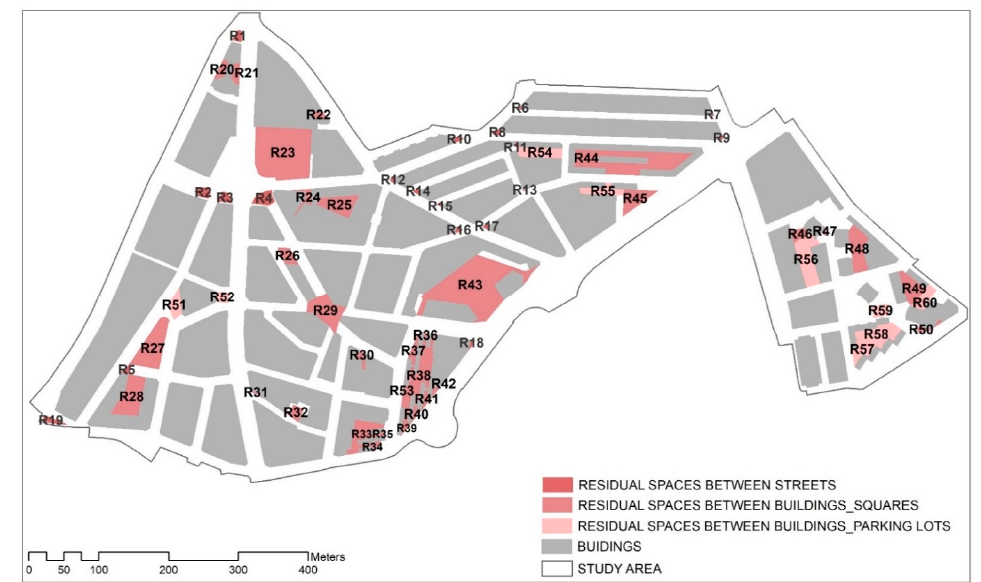
Figure 12. Map of residual surface spaces in La Milagrosa.